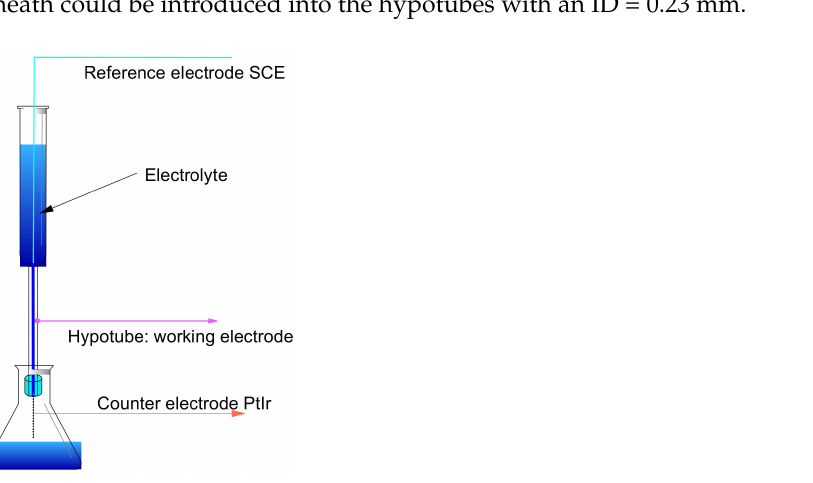
Figure 8. Assembly for the evaluation of the internal surface of the